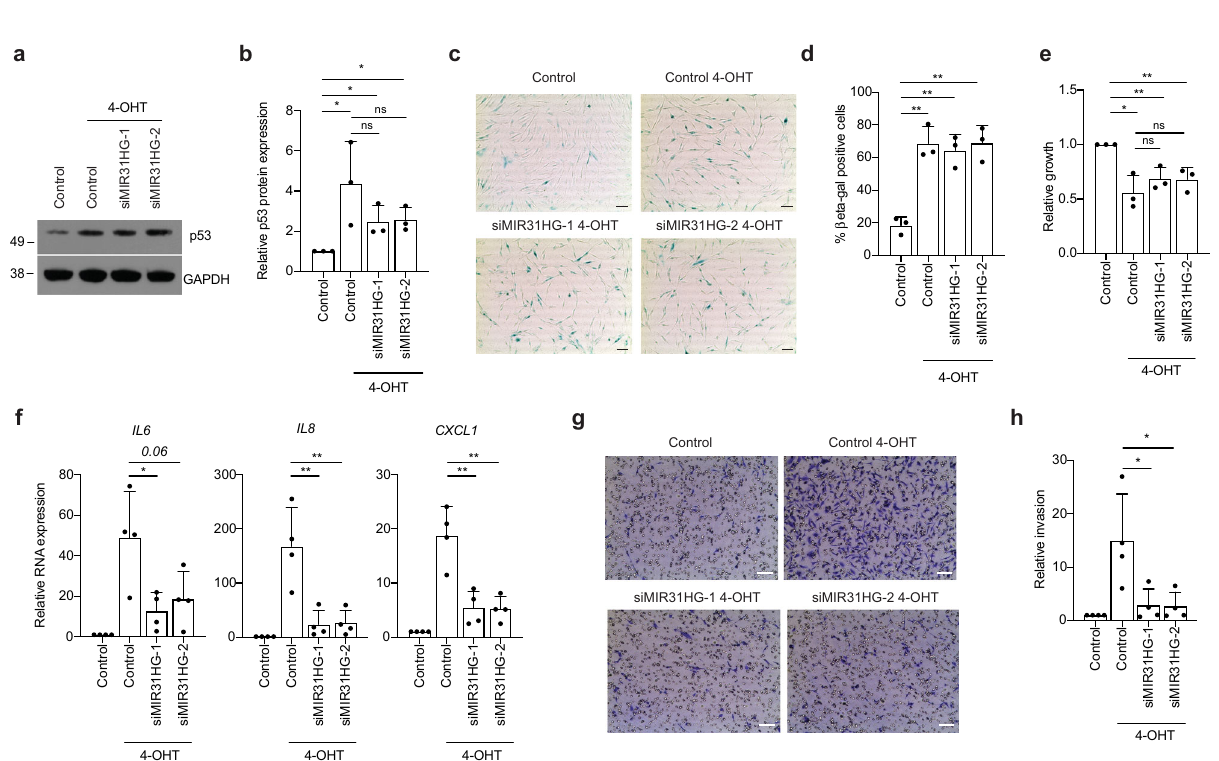
Fig. 2 The SASP of senescent MIR31HG knock-down cells induces senescence but not invasion in a non-autonomous manner. a Western blot analysis for p53 and GAPDH. in WT BJ cells incubated for 72 h with the CM collected from BJ ER:BRAF cells (Control or siMIR31HG1-2) treated with ethanol (Control) or 1 μ M 4-OHT for 72 h. Molecular weight marker is shown in kDa. b Quanti fi cation of the western blot band intensities for p53 relative to GAPDH ( n = 3). c Representative images of β -galactosidase staining from the same condition as indicated in a ( n = 3). Scale bar: 50 μ m. d Quanti fi action of the% of β -galactosidase-positive cells from c ( n = 3). e Relative growth by crystal violet staining dissolved in acetic acid and measured at 590 nm in WT BJ cells incubated for 72 h with the CM collected from BJ ER:BRAF cells (Control or siMIR31HG1-2) treated with ethanol (Control) or 1 μ M 4-OHT for 72 h. The graph shows the absorbance relative to the control cells set as 1 ( n = 3). f qRT-PCR analysis of a subset of components of the SASP normalized to housekeeping genes ( HPRT1 and RPLP0 ) in total RNA extracted from cells described in a . The graph shows the RNA expression relative to control ethanol- treated cells set to 1 ( n = 4). g MDA-MB-231 invading cells through a matrigel membrane in contact with the CM collected from BJ ER:BRAF cells (Control or siMIR31HG) treated for 72 h with ethanol (Control) or 1 μ M 4-OHT. Representative images are shown in the fi gure ( n = 4). Scale bar: 50 μ m. h Quanti fi cation of the invading cells relative to control ethanol-treated cells ( n = 3). All statistical signi fi cances were calculated using two-tailed